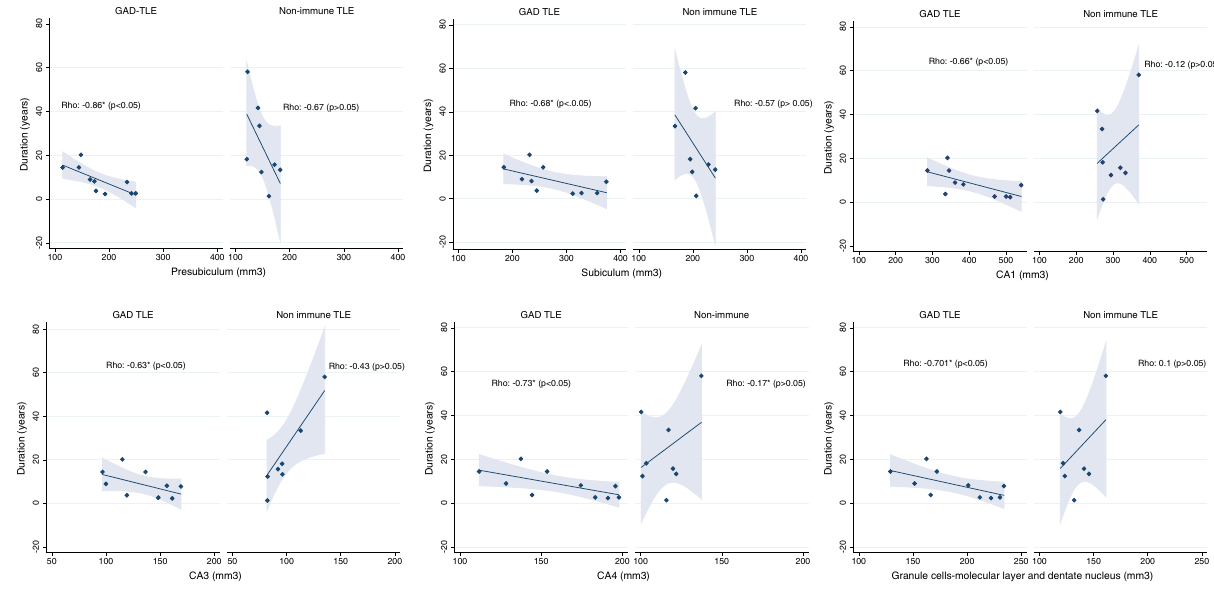
Figure 3. Hippocampal subfields and correlation with disease duration. In the plot the dots represent values for each hippocampal subfield and its correlation with epilepsy duration. On GAD-TLE patients we see a strong negative correlation in the represented subfields, while in niTLE volumes appear randomly scattered and therefore show a non-significantly weak or absent correlation. CA1–2–3–4 cornu ammonis areas 1,2–3,4, GC-ML-DG granule cells in the molecular layer of the dentate gyrus, HATA hippocampus-amygdala-transition- area.